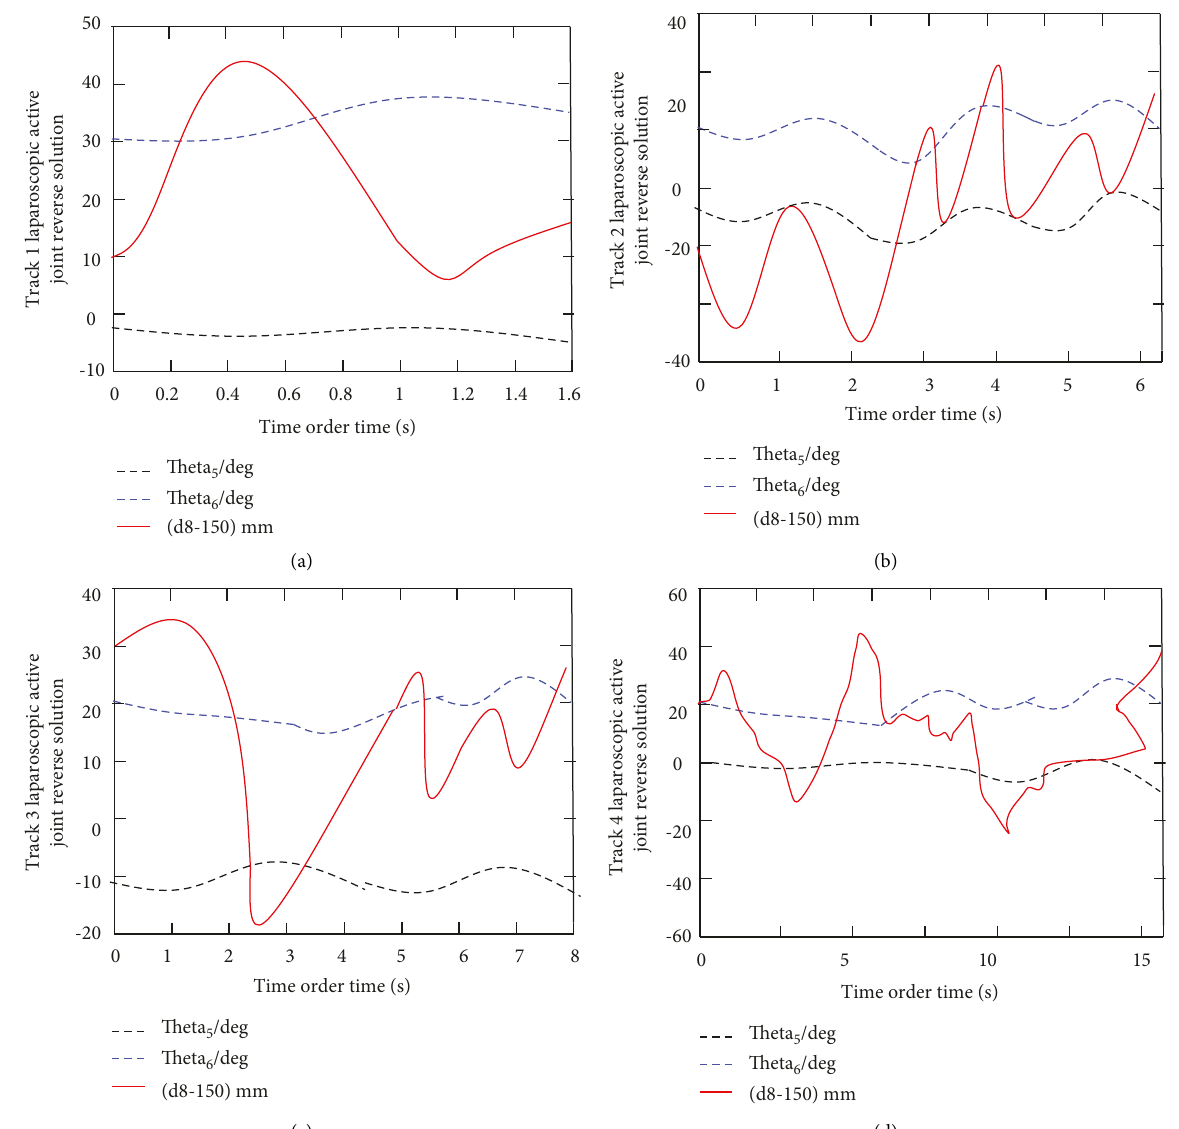
Figure 6: The result of the kinematic inverse solution of the end tracking trajectory based on the machine vision